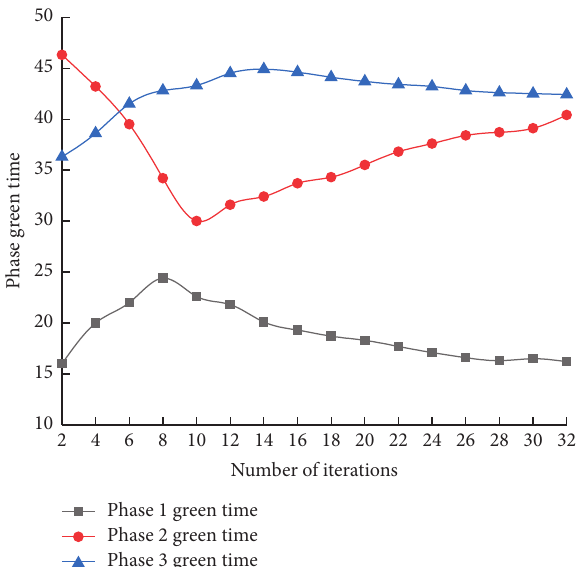
Figure 6: Green light time of each phase after iteration under iterative learning